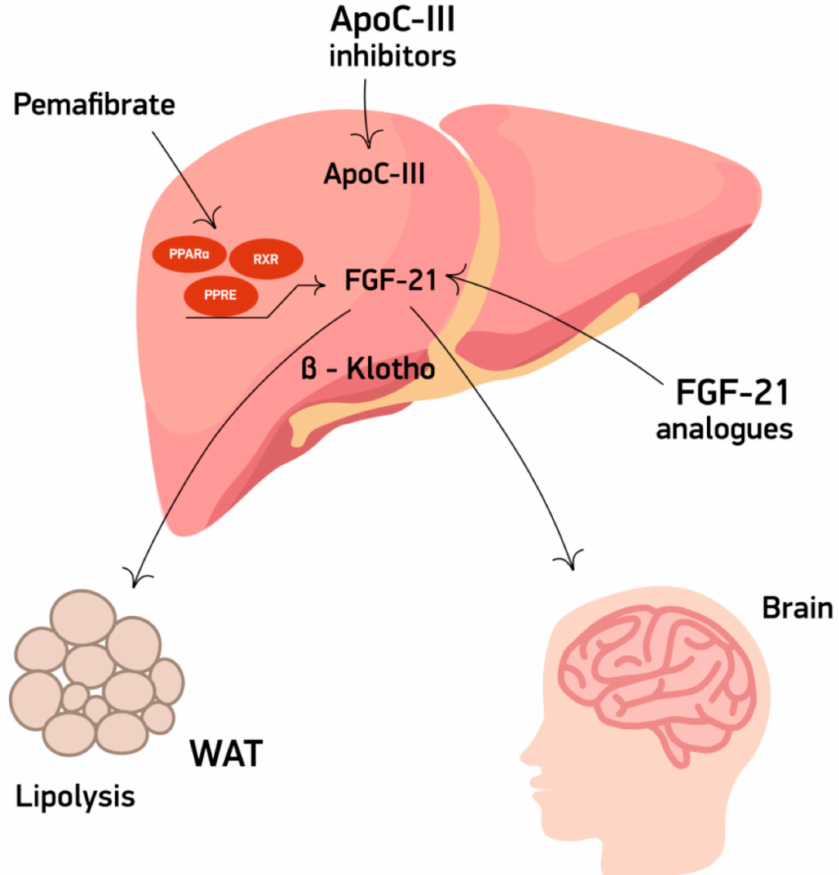
Figure 1. Mechanism of action of triglyceride-lowering agents ApoC-III: apolipoprotein C-III, FGF21: fibroblast growth factor 21, WAT: white adipose